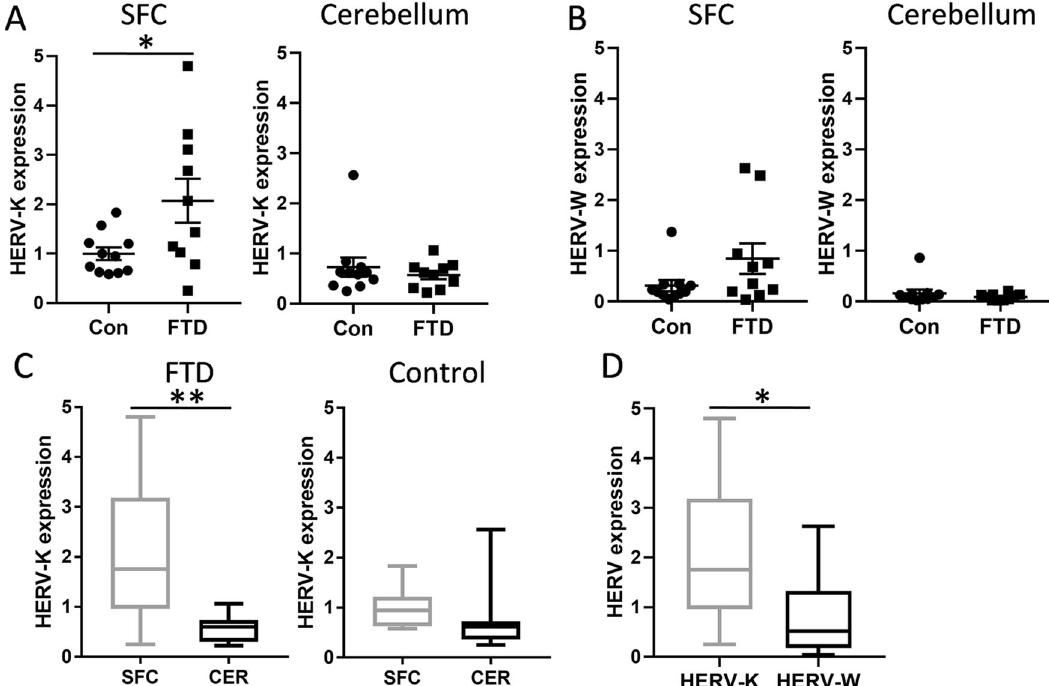
Fig. 3 Expression of HERV-K in FTD brain. A HERV-K env mRNA expression in the superior frontal cortex (SFC) and cerebellum of FTD ( n = 10) and control ( n = 11) brain as measured by qPCR. Data represent mean and SE as error bars. B HERV-W env mRNA expression in the SFC and cerebellum of FTD ( n = 10) and control ( n = 11) brain as measured by qPCR. Data represent mean and SE as error bars. C A comparison of HERV-K env expression in the SFC and cerebellum in FTD ( n = 10 SFC, n = 10 cerebellum) and control ( n = 11 SFC, n = 11 cerebellum). Data represent median with min and max as whiskers. D A comparison of HERV-K and HERV-W env expression in FTD SFC ( n = 10). Data represent median with min and max as whiskers. * P < 0.05, ** P <